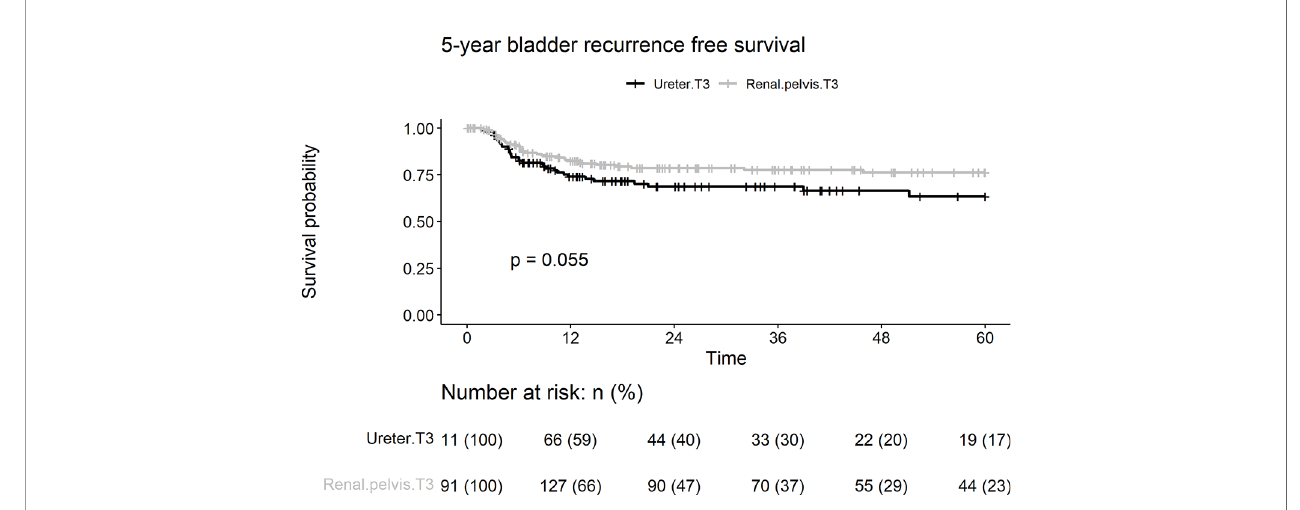
FIGURE 1 | Kaplan-Meier analyses for 5-year intravesical recurrence-free survival strati fi ed by tumor stage among patients with pT3N0M0 upper tract urothelial carcinoma following radical nephroureterectomy.